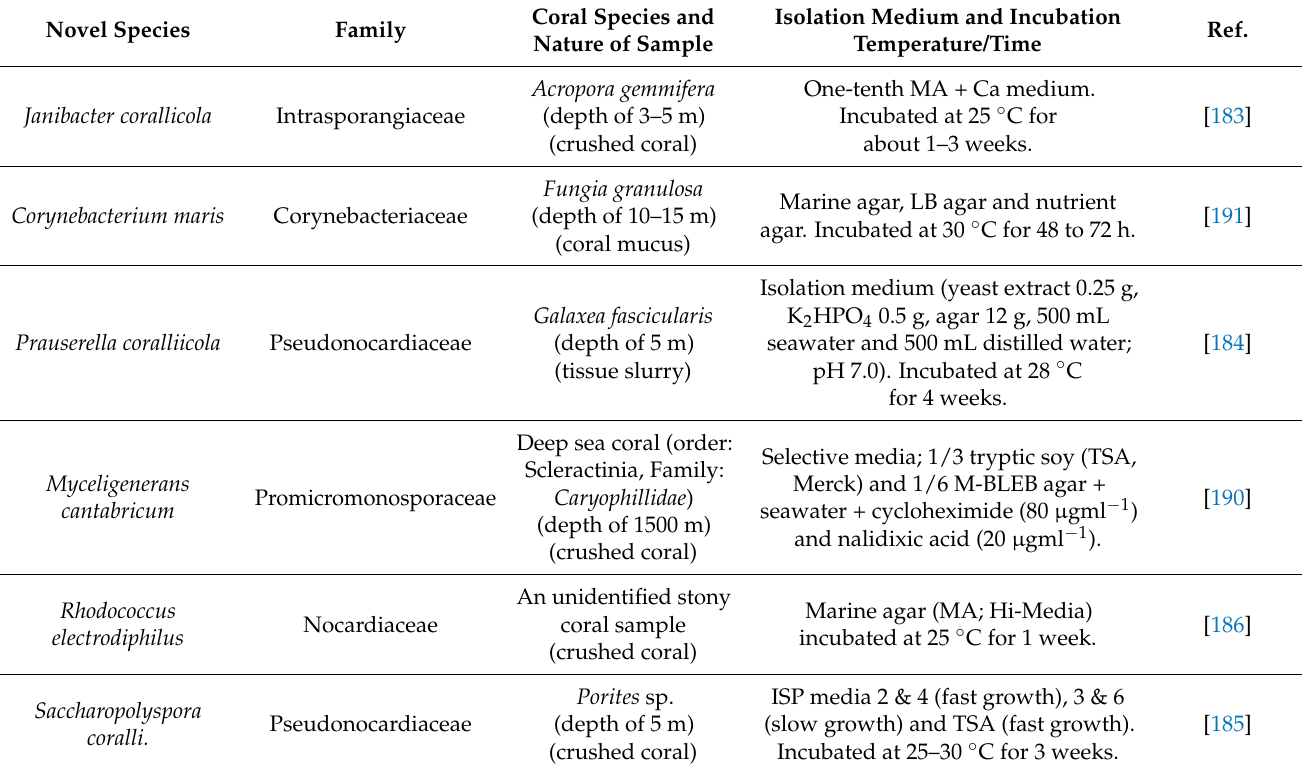
Table 2. New species of Actinobacteria from coral (order Scleractinia) reported between 2007 to